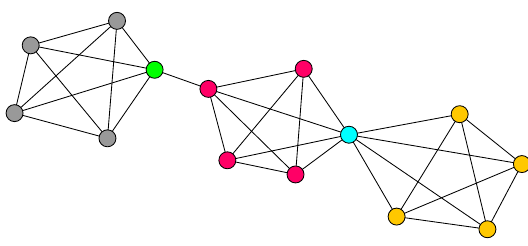
Figure 5. Identifying overlap. The cyan node overlaps the magenta and yellow clusters. Despite having adjacencies to two clusters, the green node is not an overlap